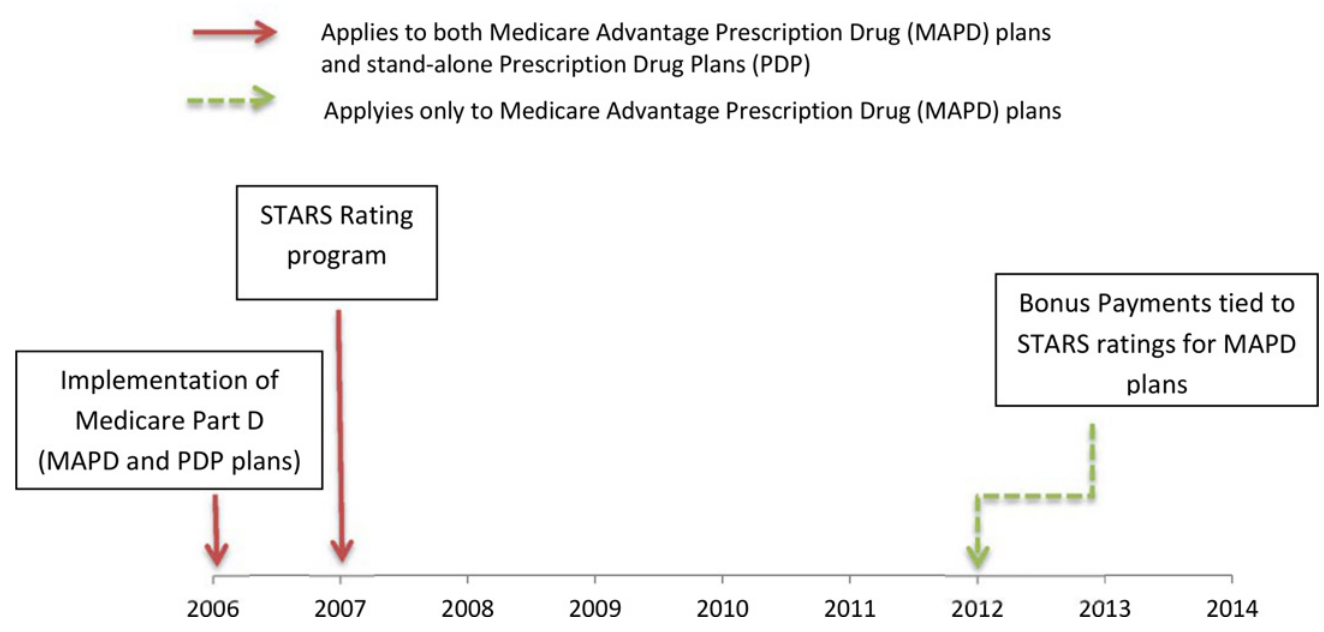
Fig 1. Timeline of Medicare Plan Quality Rating and Pay for Performance System.